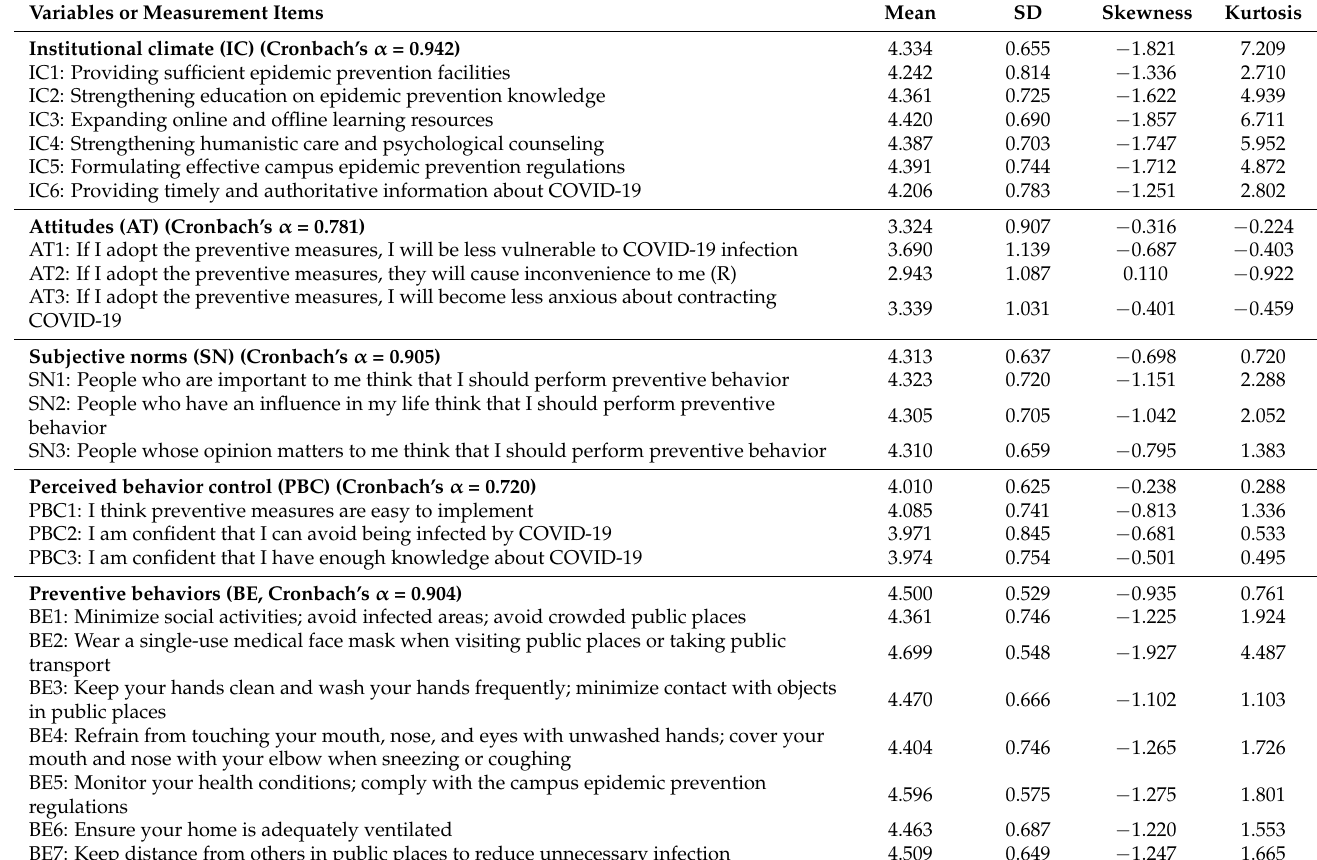
Table 2. Scale items and descriptive